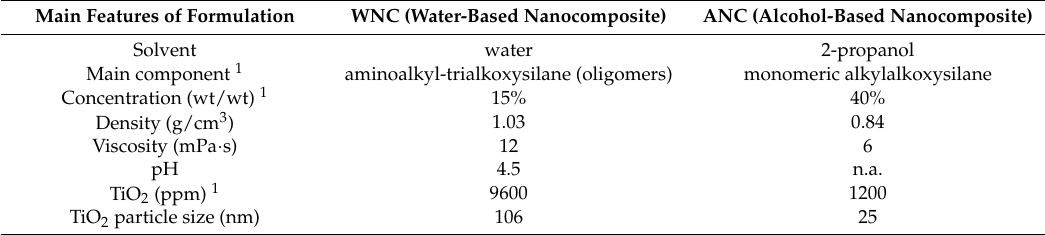
Table 2. Main chemical properties of the two